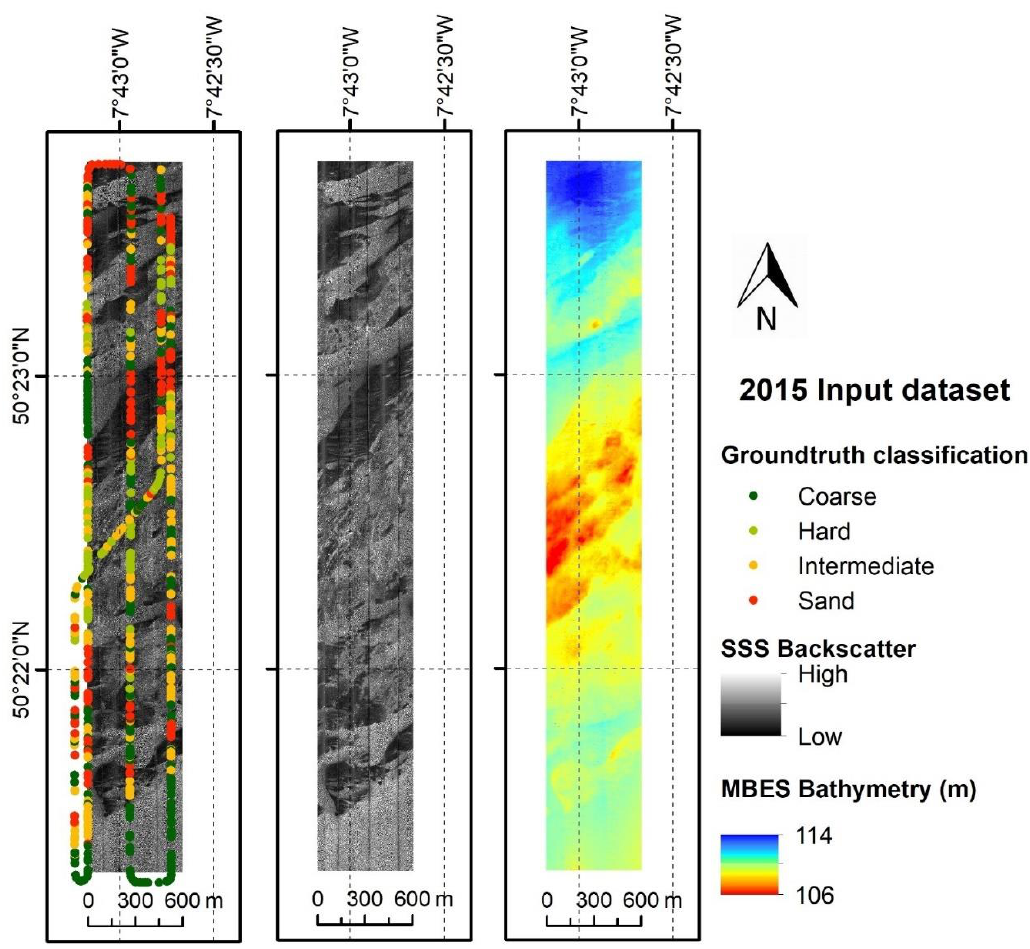
Figure 3. Geophysical datasets and groundtruth data points from 2015 survey. Left, AUV sidescan sonar map from Day 1, with classified groundtruth points. Middle, sidescan sonar map from Day 2. Right, shipboard bathymetry data of the same area. Mercator projection with standard parallel 50. WGS84 datum. Table 2. Multibeam echosounder bathymetry acquisition parameters.